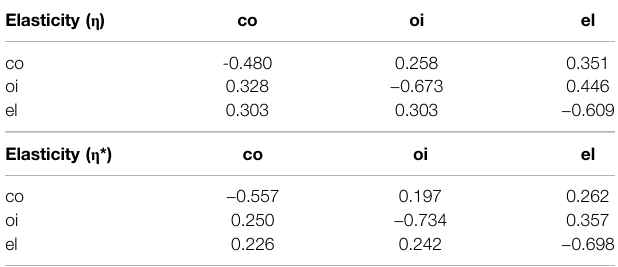
TABLE 2 | The estimating fuel price elasticities in China ’ s EIIs.